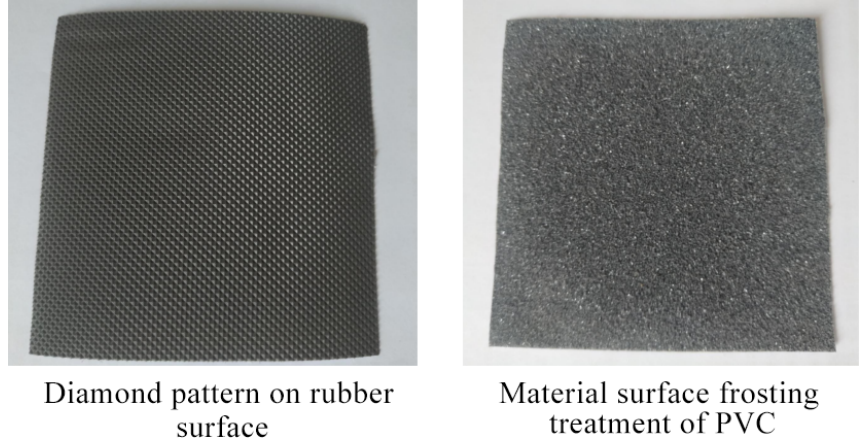
Figure 13. Surface material of end-effector roller. (a) Diamond pattern on the rubber surface. (b) Material surface frosting treatment of